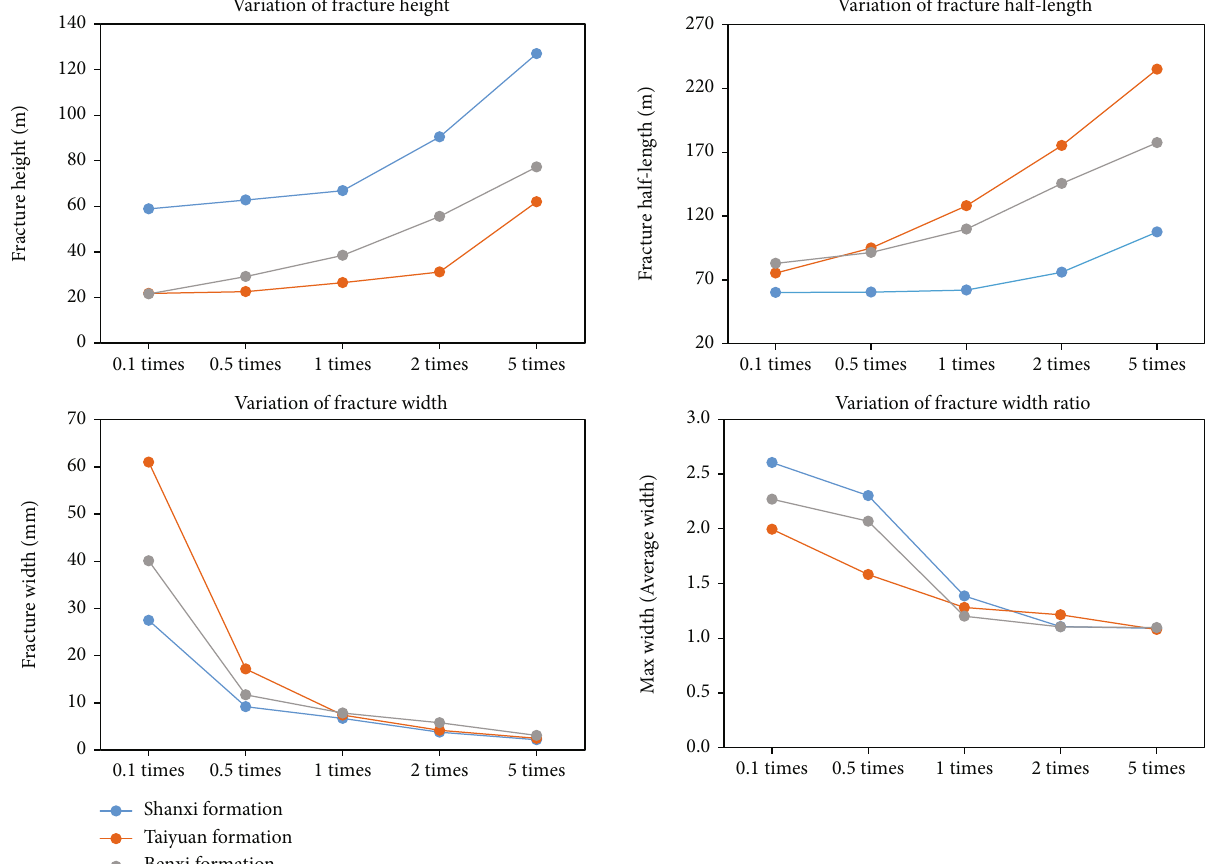
Figure 11: Variation of hydraulic fracture shape with the fracturing fl uid injection